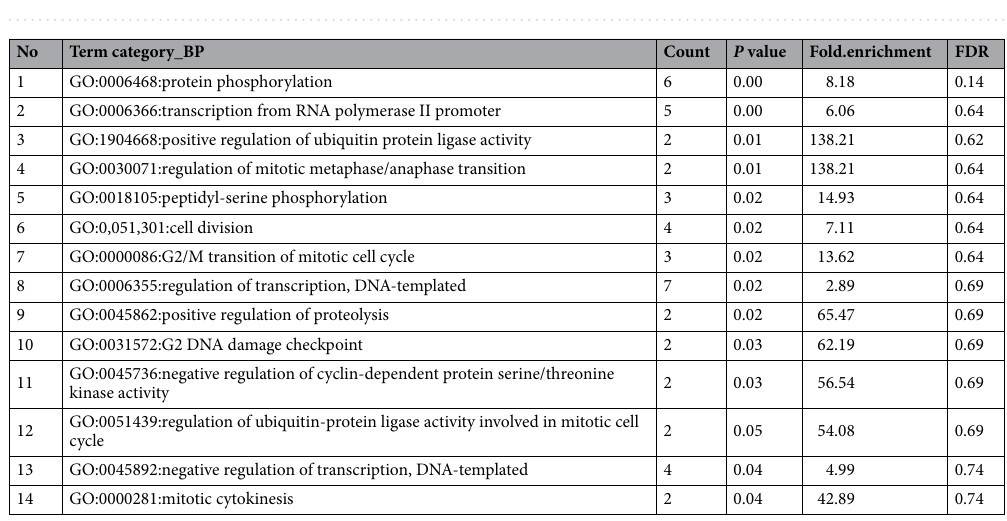
Figure 7. Visualization and functional annotation of candidate genes. Venn diagram showing all identified hub genes and their overlap in WGCNA-blue and MEGENA-C1_5 ( A ), and WGCNA-green and MEGENA-C1_7 ( B ). ( C ). Each box indicates the expression level of each candidate gene (row) in each sample (column). The red indicates the high expression, while the blue indicates the low expression. Similarly, an R package heatmap is used in this figure. And two-way hierarchical clustering is used for clustering. ( D ). GO enrichment analysis was performed on the candidate genes.